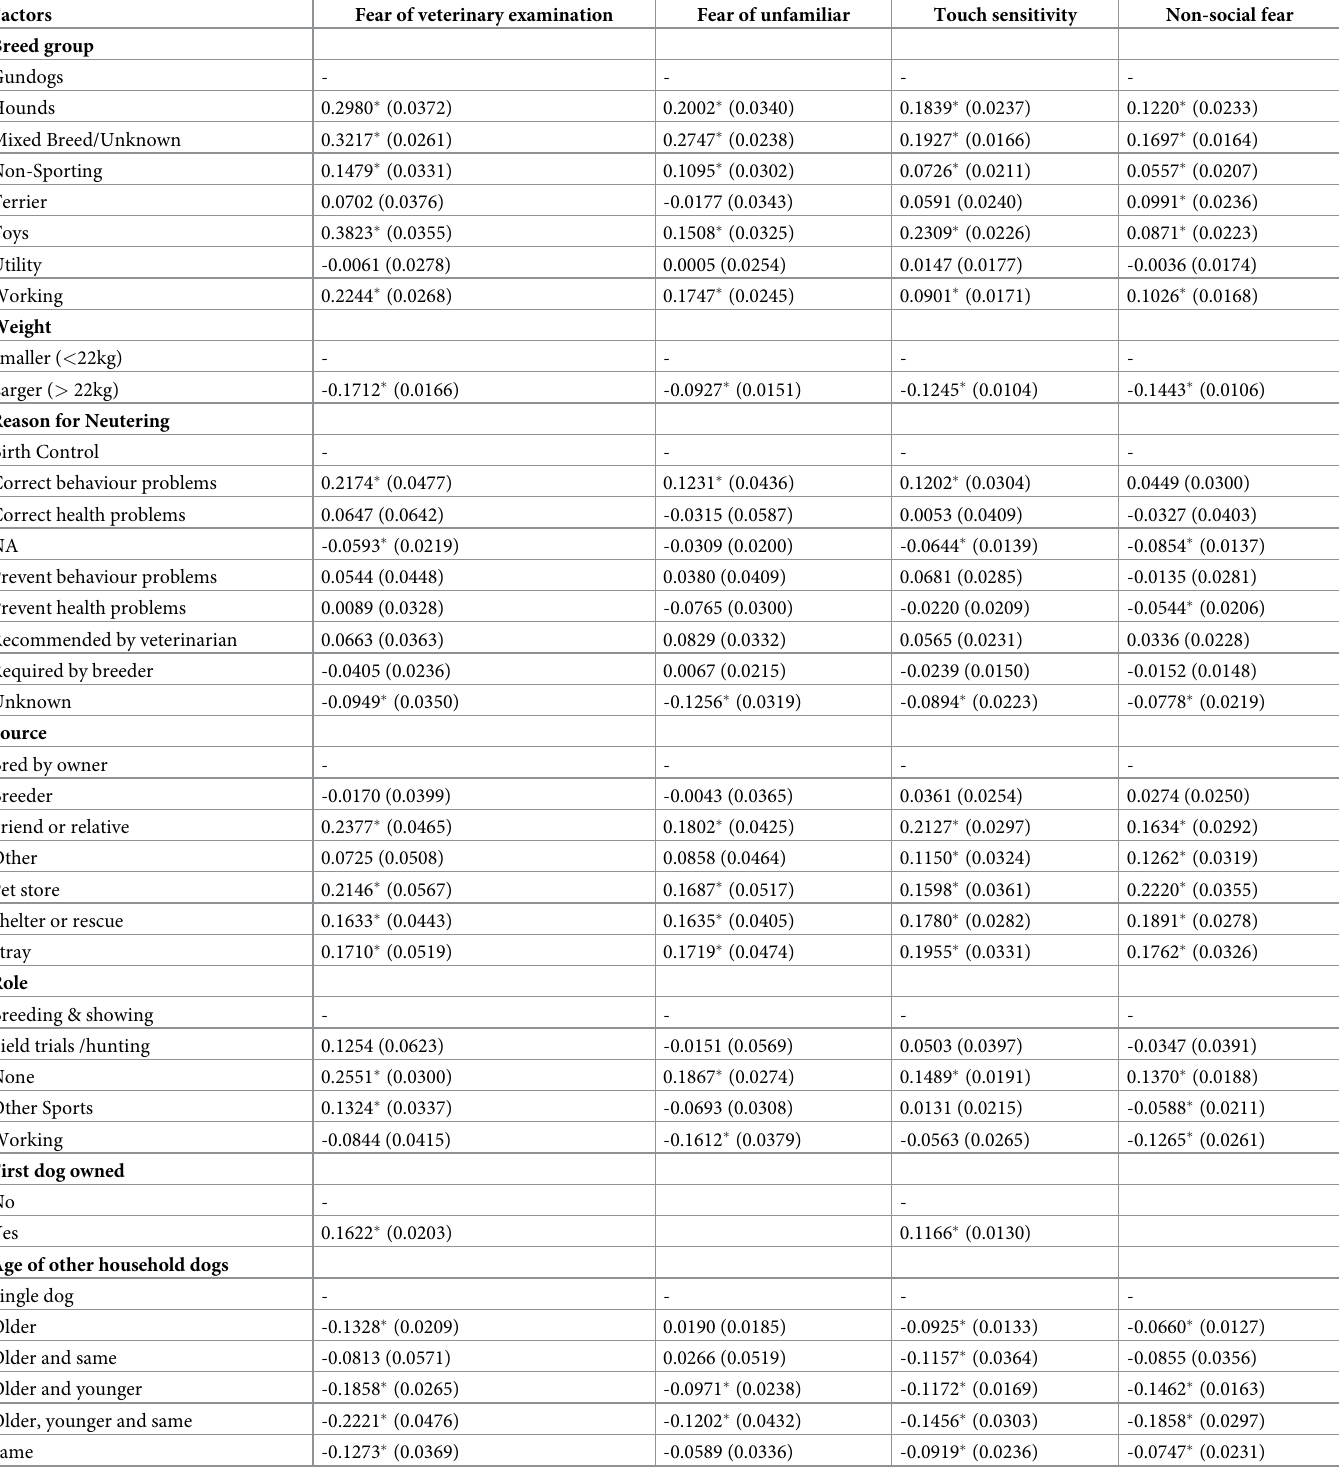
Table 2. Summary of multivariate regression models indicating the predicted severity of fear response (unstandardised Beta coefficients ( B ) and standard error (SE)) by factor during veterinary examination, unfamiliar situations, touch sensitivity and non-social